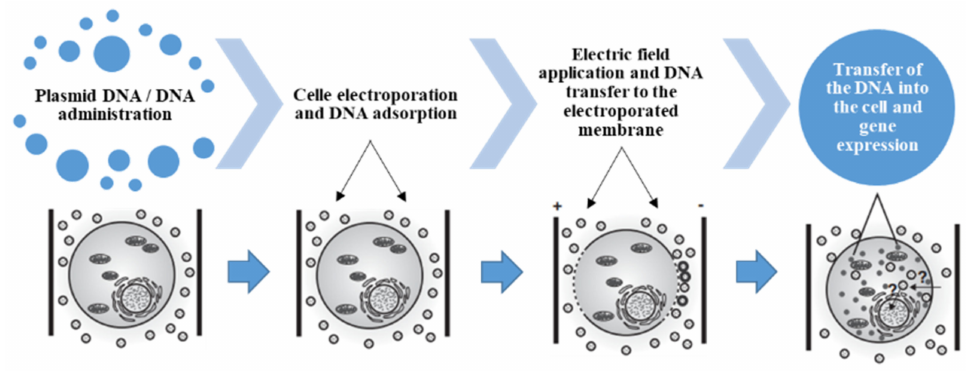
Figure 1. Schematic representation of gene transfer